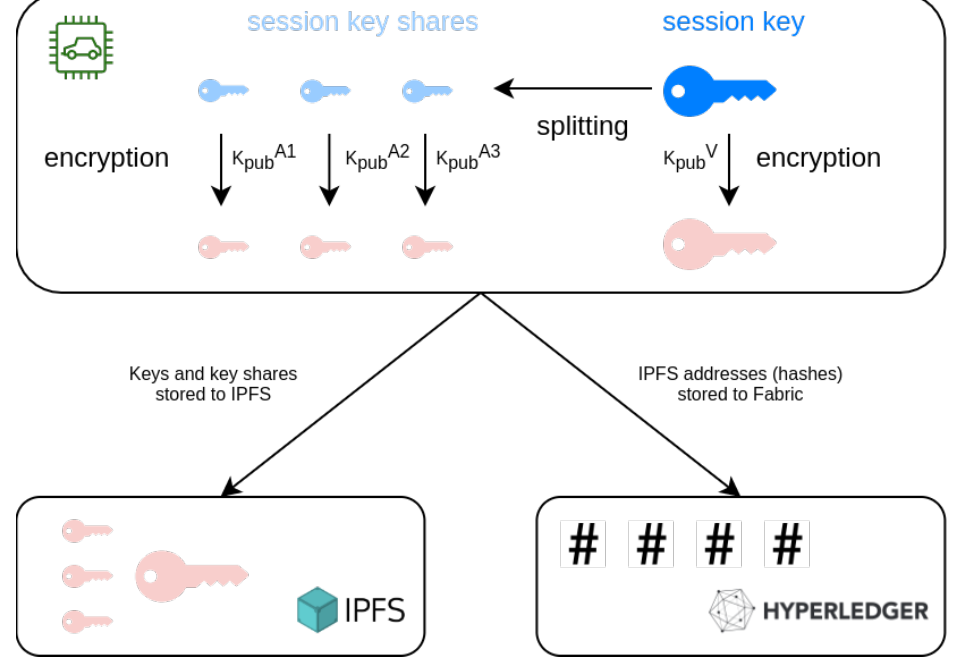
Figure 3. Session key